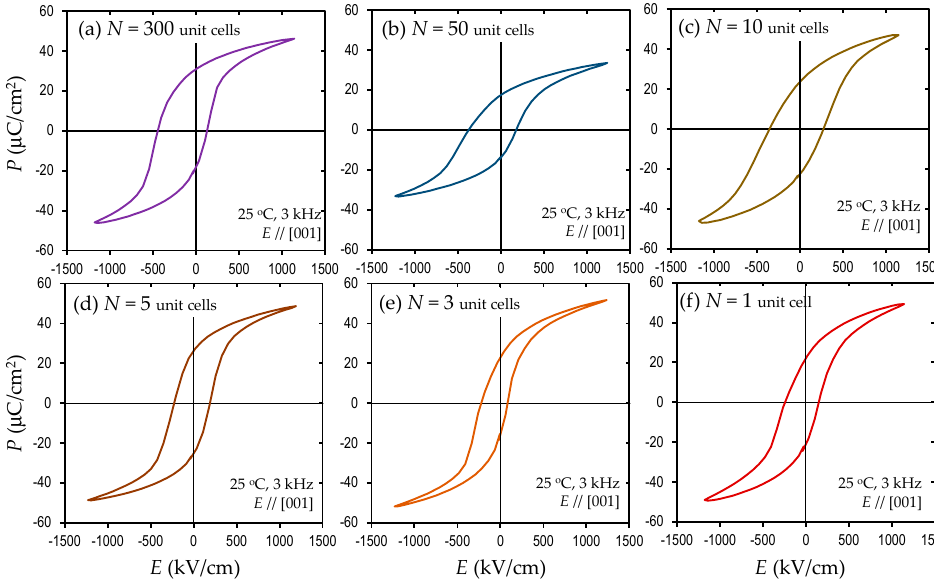
Figure 5. Polarization ( P ) electric field ( E ) hysteresis loops at 25 ℃ , for ( a ) N = 300, ( b ) N = 50, ( c ) N = 10, ( d ) N = 5, ( e ) N = 3 and ( f ) N = 1, where an E of 3 kHz is applied along [001], where N denotes the number of ABO 3 unit cells in the two layers of Mn-BiFeO 3 and BaTiO 3 comprising the superlattice.